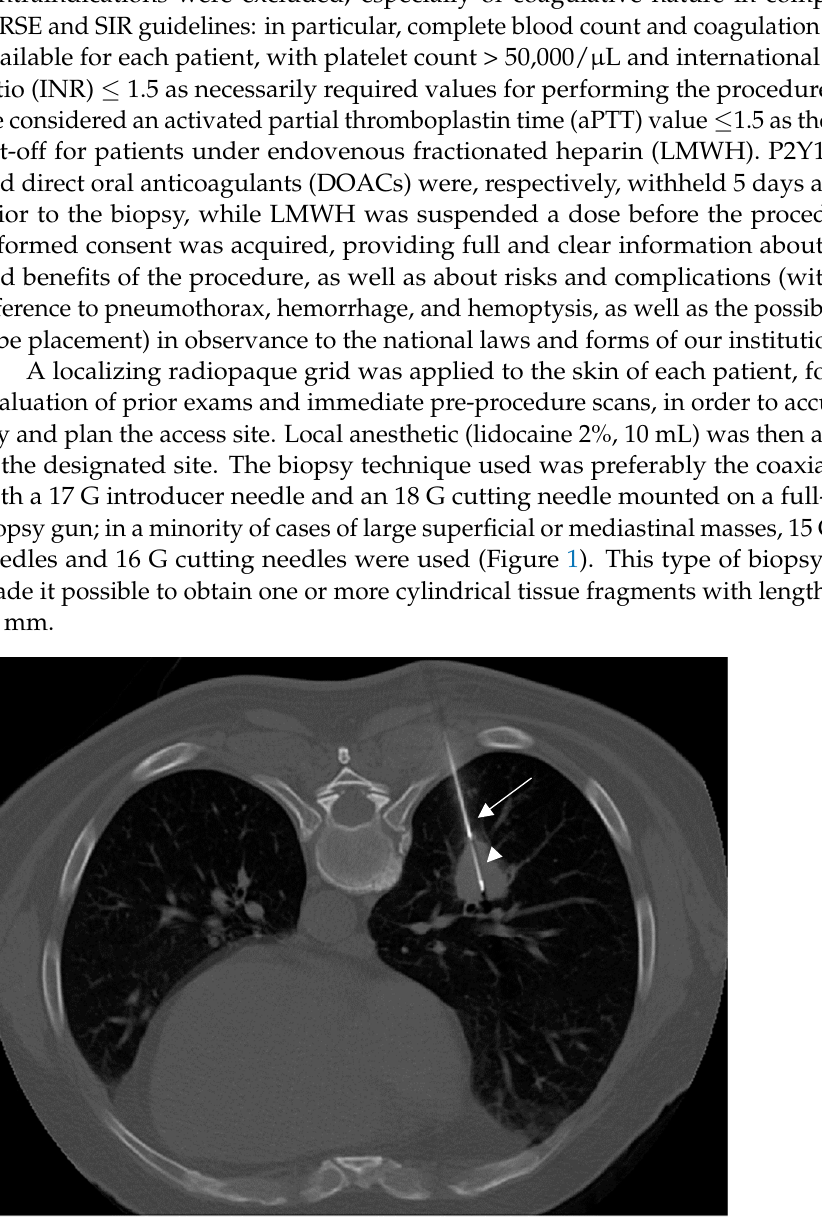
Figure 1. Core-needle biopsy of a central solid nodule of the lower left lobe; the extremity of the cutting needle appears in the center of the lesion (arrowhead), while the 17 G coaxial introducer needle was placed adjacent to the lesion (arrow). Pathological diagnosis demonstrated a moderately differentiated squamous cell carcinoma.